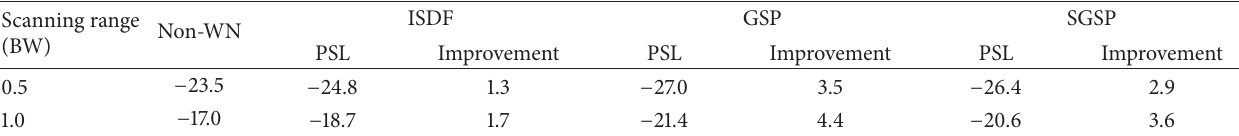
Table 1: The PSL of array pattern with SBS